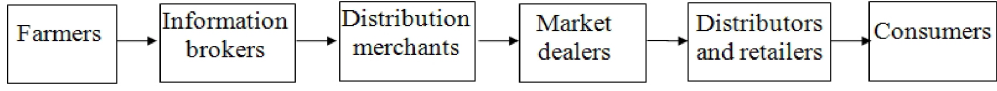
Figure 2. Subjects relationship of Loose